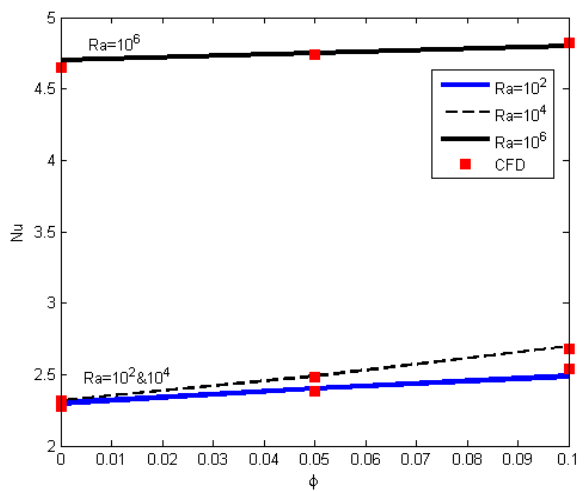
Figure 8. The Nusselt number survey relative to the volume of nanoparticles at Ha = 40, AR = 0.5, and α = 0.